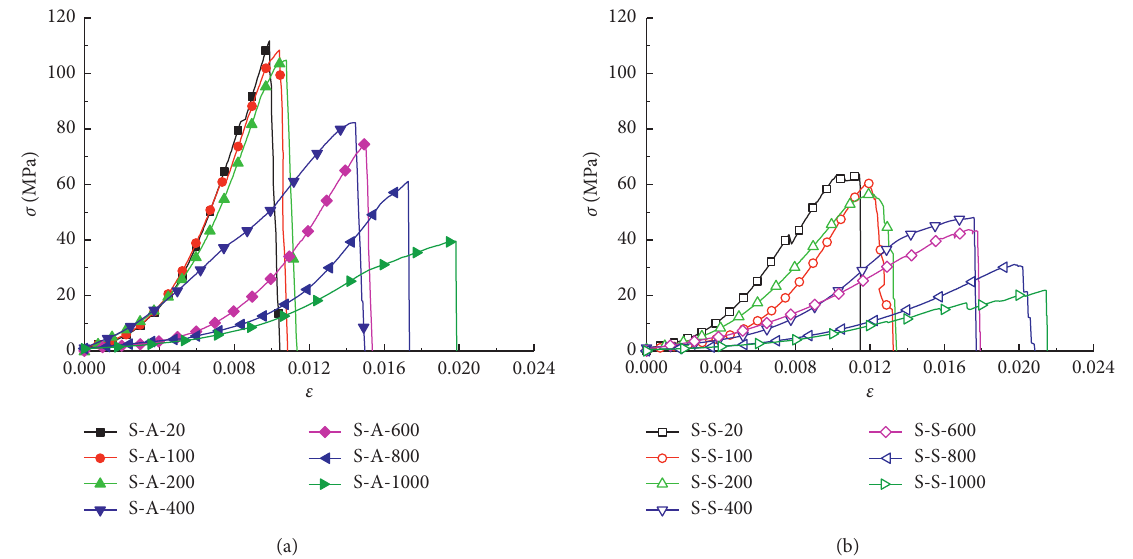
Figure 5: Static uniaxial compression stress-strain curves of argillaceous sandstone after high temperature. (a) Air-dried state. (b) Sat- uration